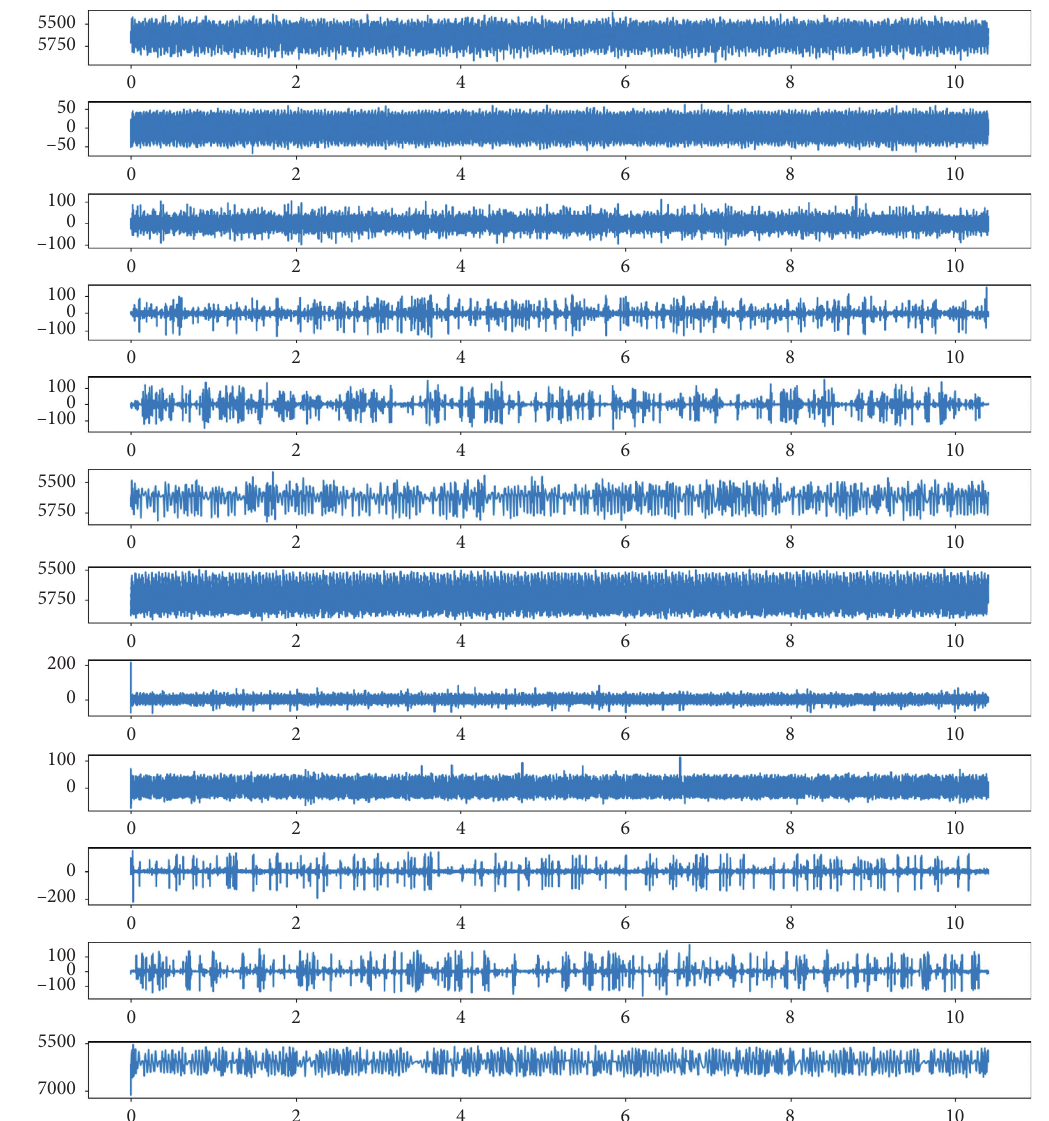
Figure 12: PF component and spectrum diagram of LMD. Two faults are large gear broken teeth and small gear wear and large gear pitting and small gear